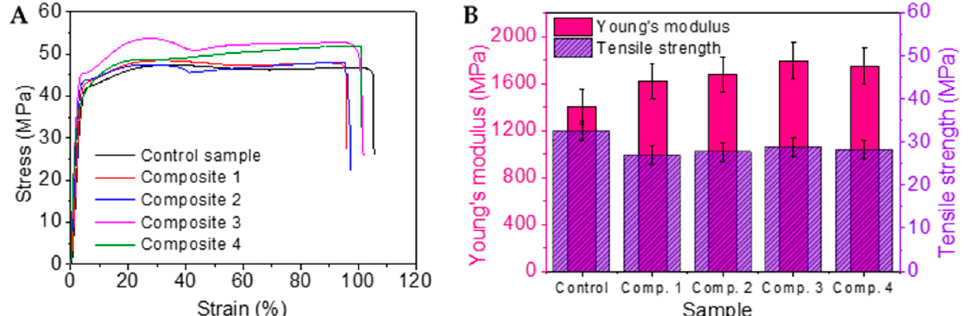
Figure 4. Properties of self-reinforced composites: ( A ) Tensile stress-strain curves, ( B ) Comparative tensile properties.